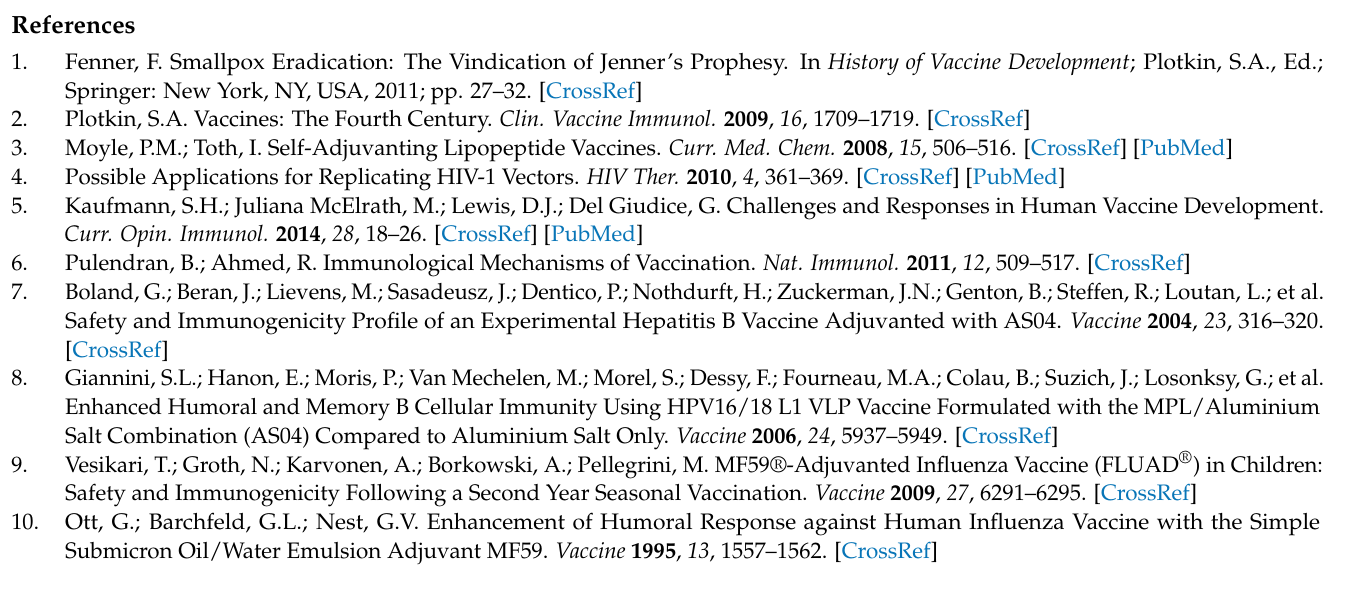
Figure S22. Release of CysR5-Phl p 5 peptide-antigen conjugate 1c; Figure S23. Scanning electron micrographs (SEM) of silica particles; Figure S24. Zeta potential of CysR5 (1 (cid:48) ), RRIL-1 (2 (cid:48) ), RRIL-2 (3 (cid:48) ) and RRLL (4 (cid:48) ) silica particles; Figure S25. Pore size distribution; Table S1. Calculated via ProtParam by